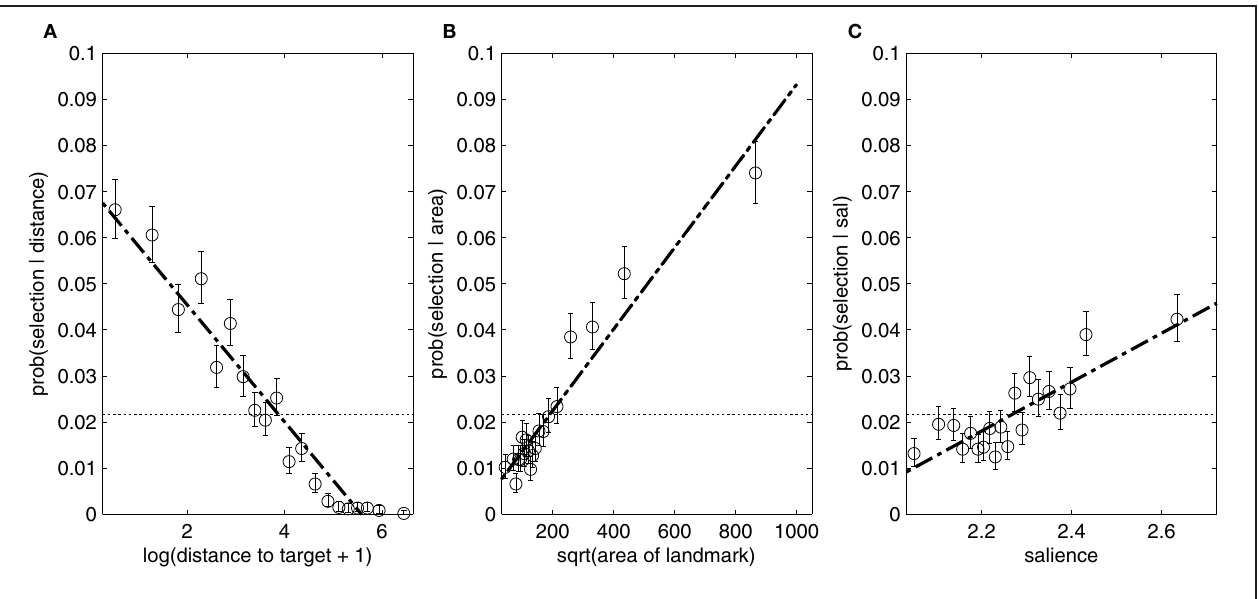
FIGURE 7 | The effect of each feature on the conditional probability of naming a given object: (A) distance, (B) area, (C) salience. These figures were generated by dividing each feature range into 5% quantiles, and plotting